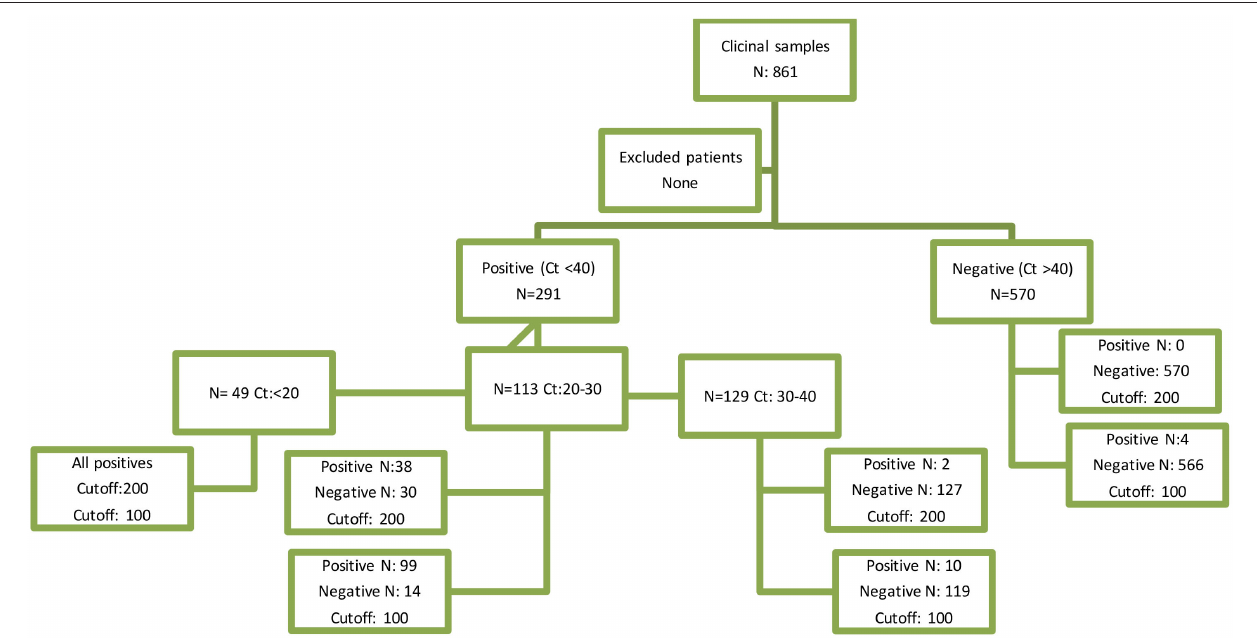
FIGURE 1 | STARD diagram. STARD, standards for the reporting of diagnostic accuracy studies.